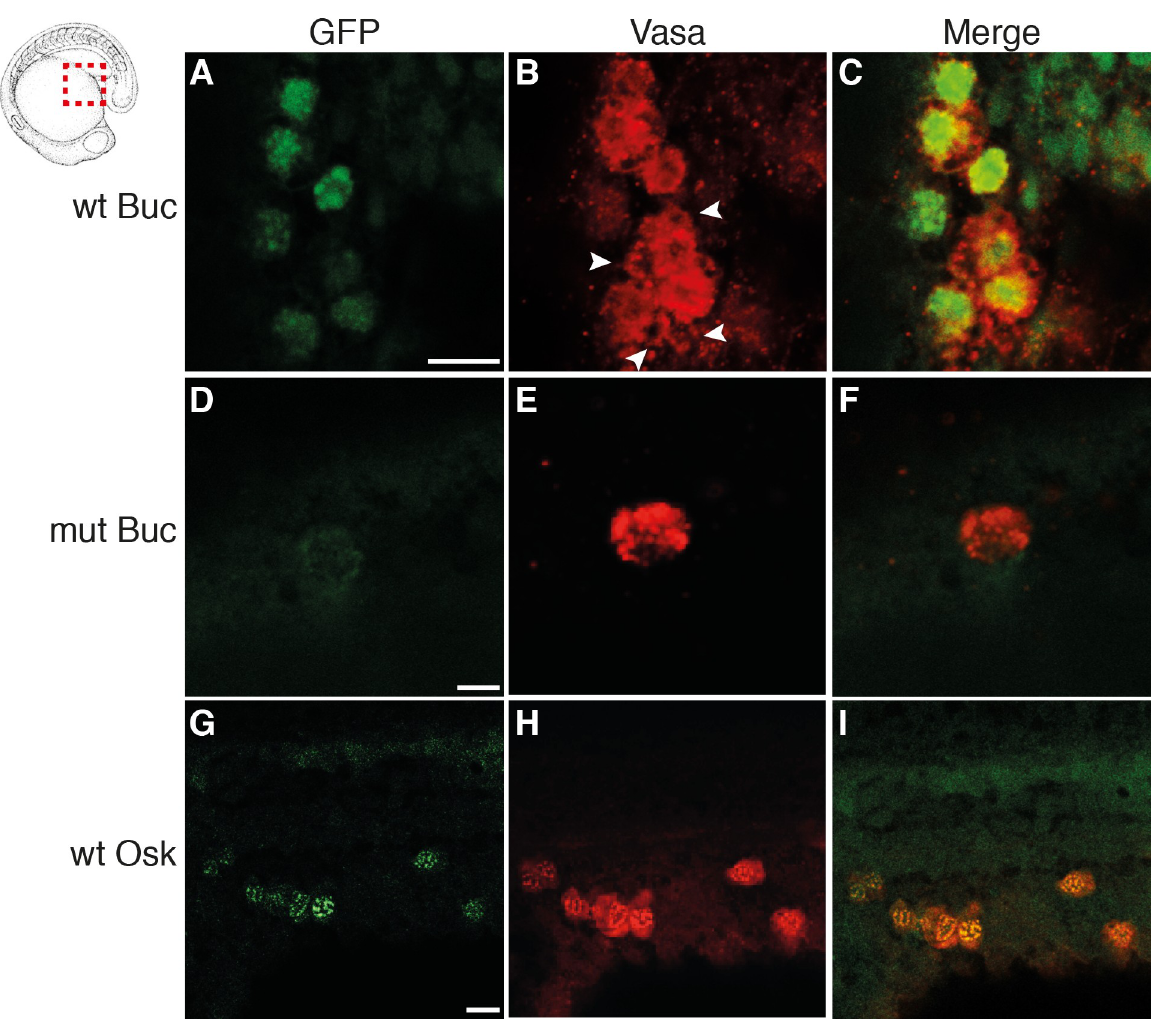
Fig 2. Buc and Osk induced PGCs express Vasa protein. Lateral view, anterior to the left of area indicated in icon of 18-somite stage embryo after 16-cell assay with wt Buc(1–639) (A-C), mutant Buc(1–361) (D-F) or sOsk (G-I). Embryos were analyzed for GFP (green) and Vasa (red) protein expression. Arrowheads indicate endogenous PGCs (Vasa positive and GFP negative). Scale bar: 20 μ